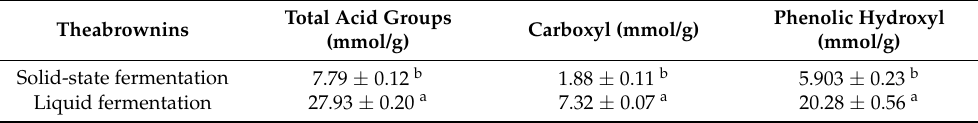
Table 8. The content of acidic functional groups of theabrownins in solid and liquid